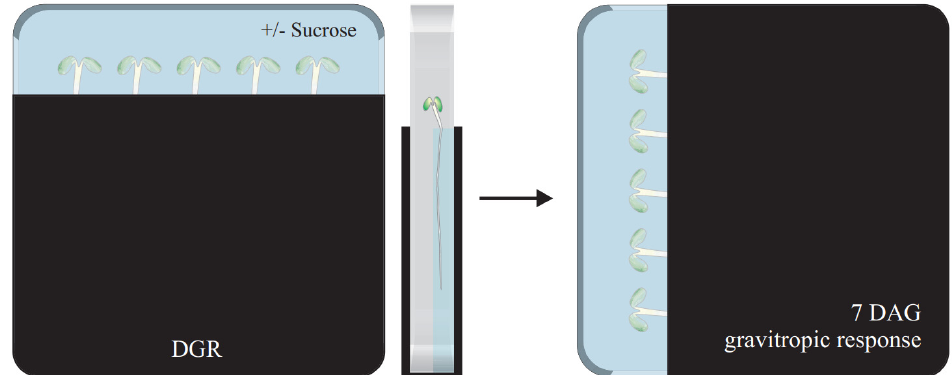
Figure 1. Schematic representation of the experimental setup. Briefly, seeds were placed on top of an agar layer unsupplemented or supplemented with sucrose. Plates were kept in the D–root system, allowing seedlings to grow with shaded roots for seven days. Primary root parameters (e.g., penetration frequency, root length, vertical growth index, straightness, and skewing angle) and gravitropic response were measured after a 90 ◦ turn. DGR: dark-grown root, DAG: days after germination.